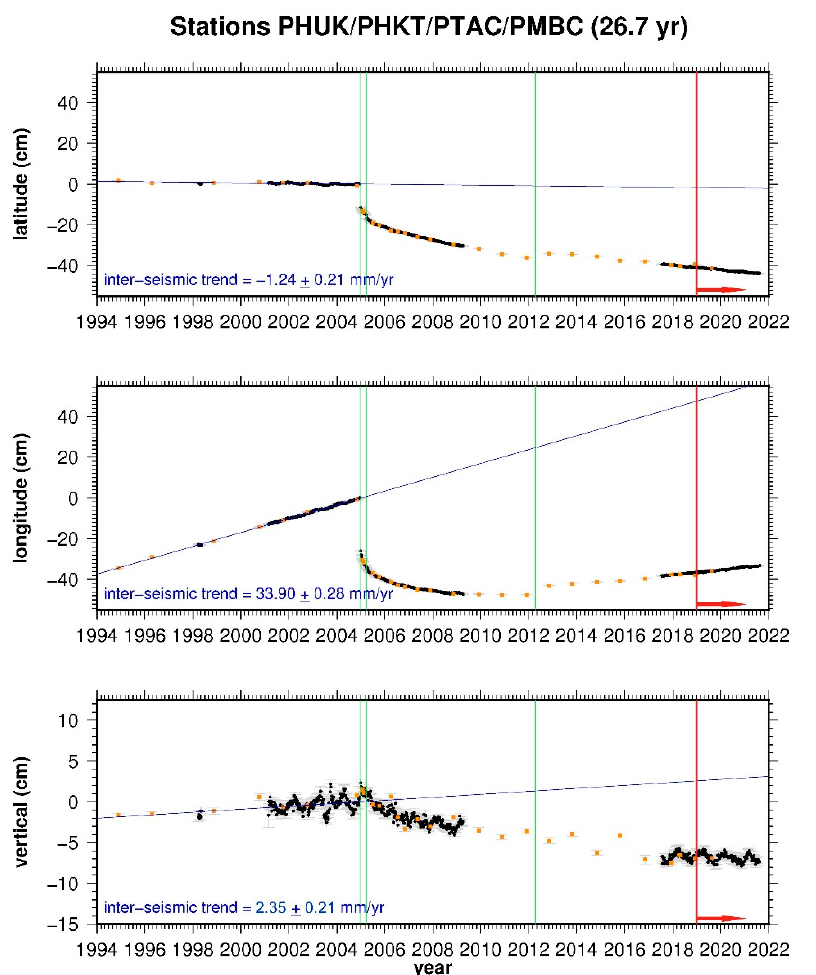
Figure 3. Updated (from Simons et al. [2]) combined station GPS (weekly averaged) position time series (1994–2021) for Phuket Island in IGS14. For each direction (N (latitude), E (longitude) and U (vertical)) the inter-seismic (1994–2004) velocity estimates and trend line are shown in blue. The time reference point was everywhere set to 25/12/2004, the last day before the Mw 9.2 earthquake. The orange dots mark the position solutions from the yearly PHUK (3–7 days) GPS point surveys. The PHUK point is also the reference benchmark for the Phuket Island time series. Uncertainties of both the trend estimates and positions are given as 1-sigma standard deviations (SD). Green vertical lines mark the 2004, 2005 and 2012 earthquakes, originating from the Sumatra Trench, which each resulted in significant horizontal co-seismic displacements of Phuket Island. The vertical red line and arrow indicate the part of the time series that has been updated, which also includes one more re-survey of the PHUK GPS point .